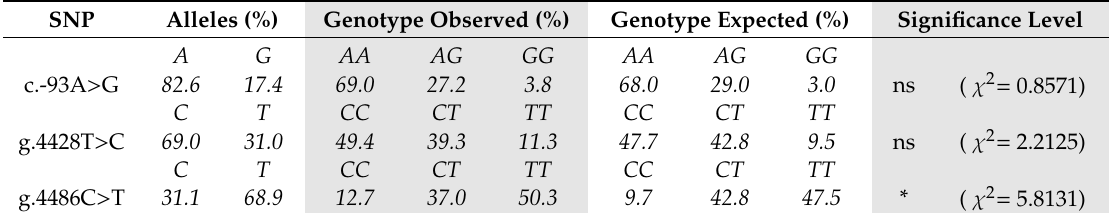
Table 3. Frequencies of genotypes and alleles between di ff erent SNP for analyzed population ( n = 346). SNP Alleles (%)